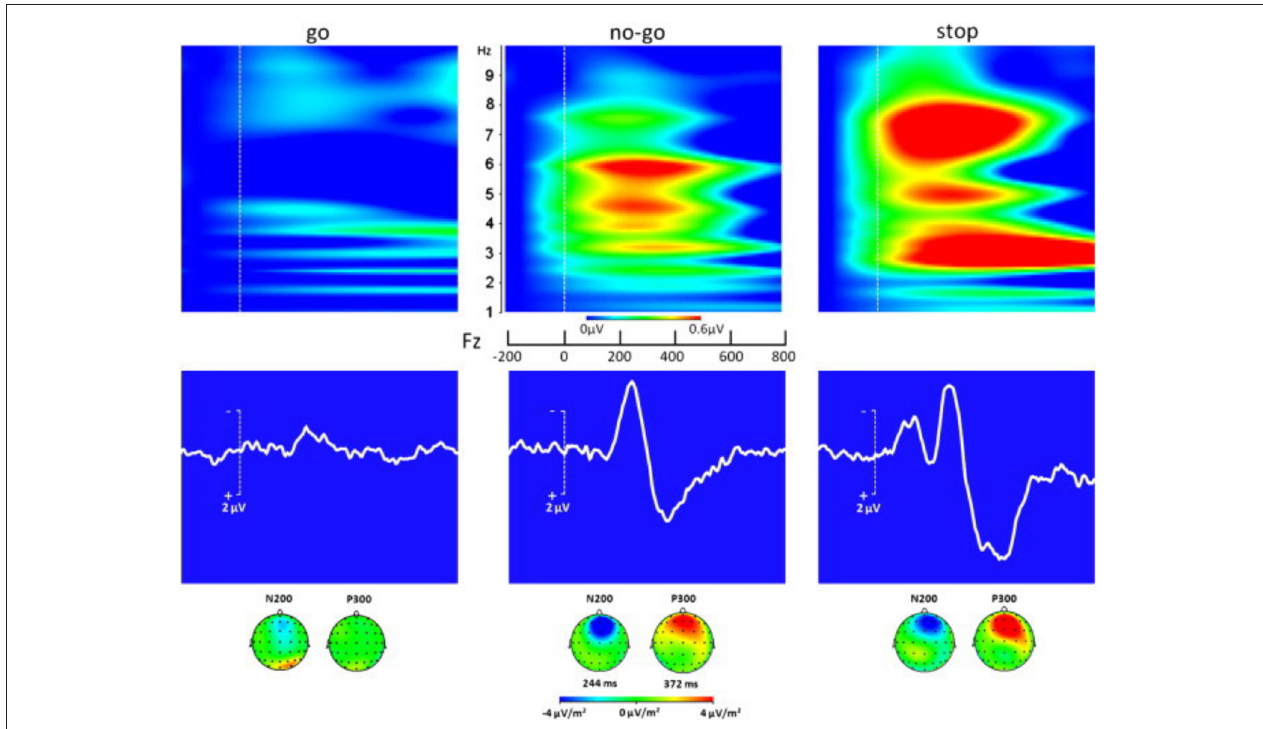
FIGURE 2 | ERP responses in a subject performing go, no-go, and stop tasks. The middle row shows the ERPs; the top row shows the associated time-frequency decompositions; and the bottom row shows how the N200 and P300 potentials are distributed over the scalp (Adapted with permission from Huster et al., 2013).